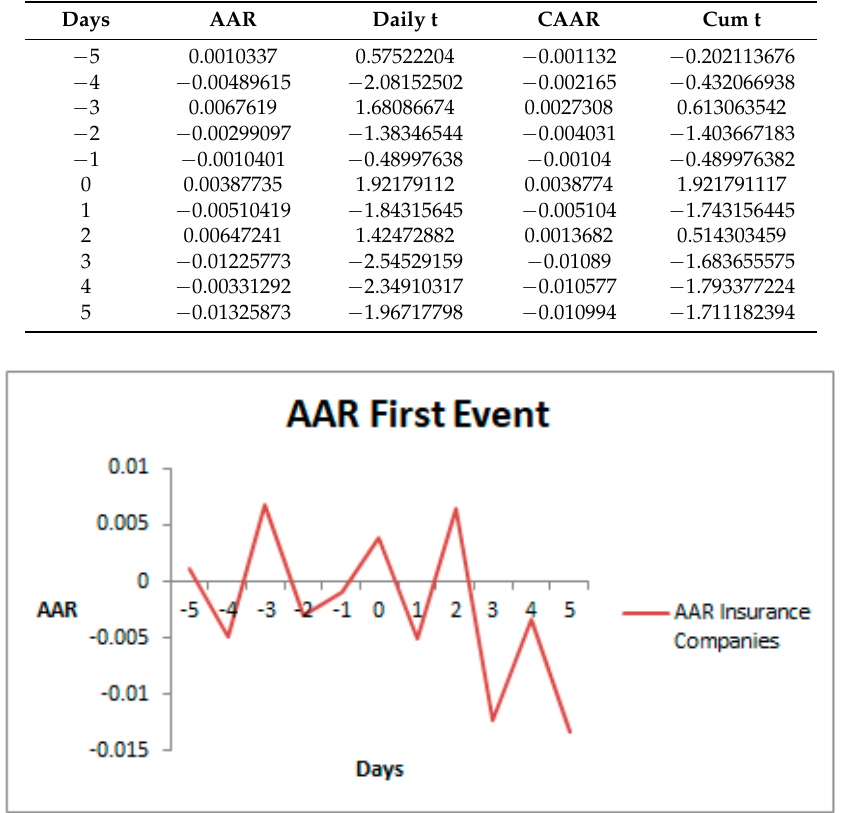
Figure 10. AAR for insurance companies. Source: Authors’ work. Table 7. Event study of insurance companies for the second event. Source: Authors’ work.